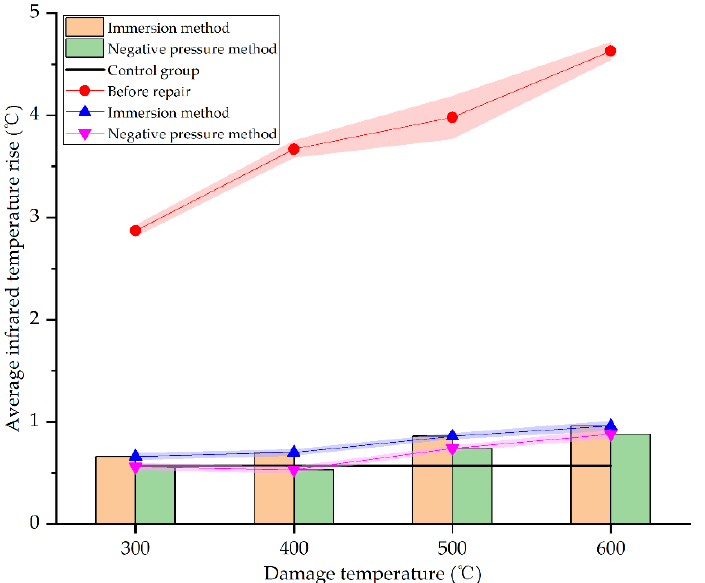
Figure 15. Average infrared temperature increase before and after repair by different methods and at different damage temperatures.